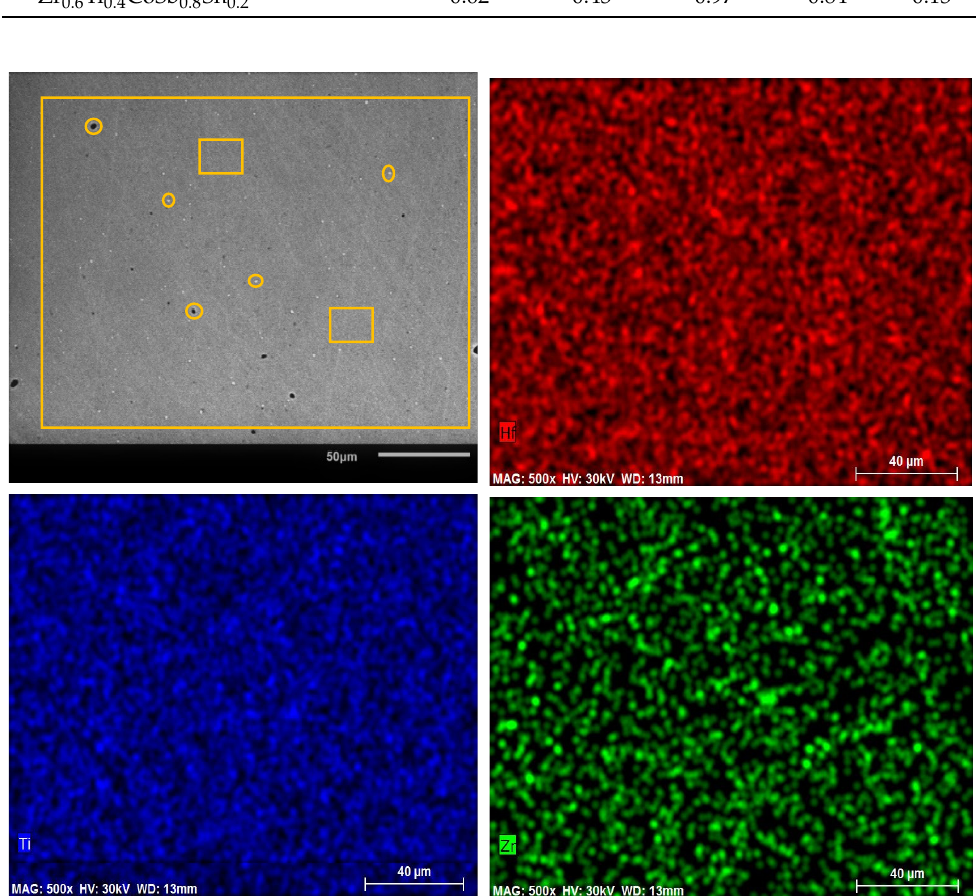
Figure 2. Typical back-scattered image and elemental mapping of (Hf,Zr,Ti)Co(Sb,Sn) hot-pressed samples synthesized via MA. Figure 3a shows a representative image of the morphology of the